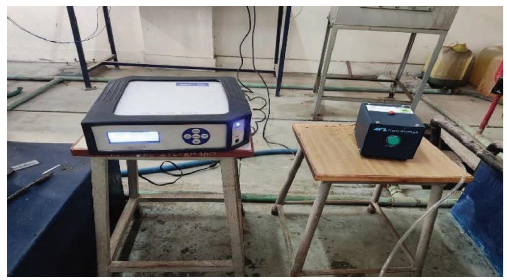
Figure 2: AVL 444N gas analyzer. Table 2: Emission measurement range of the AVL gas analyzer (DIGAS 444N model).